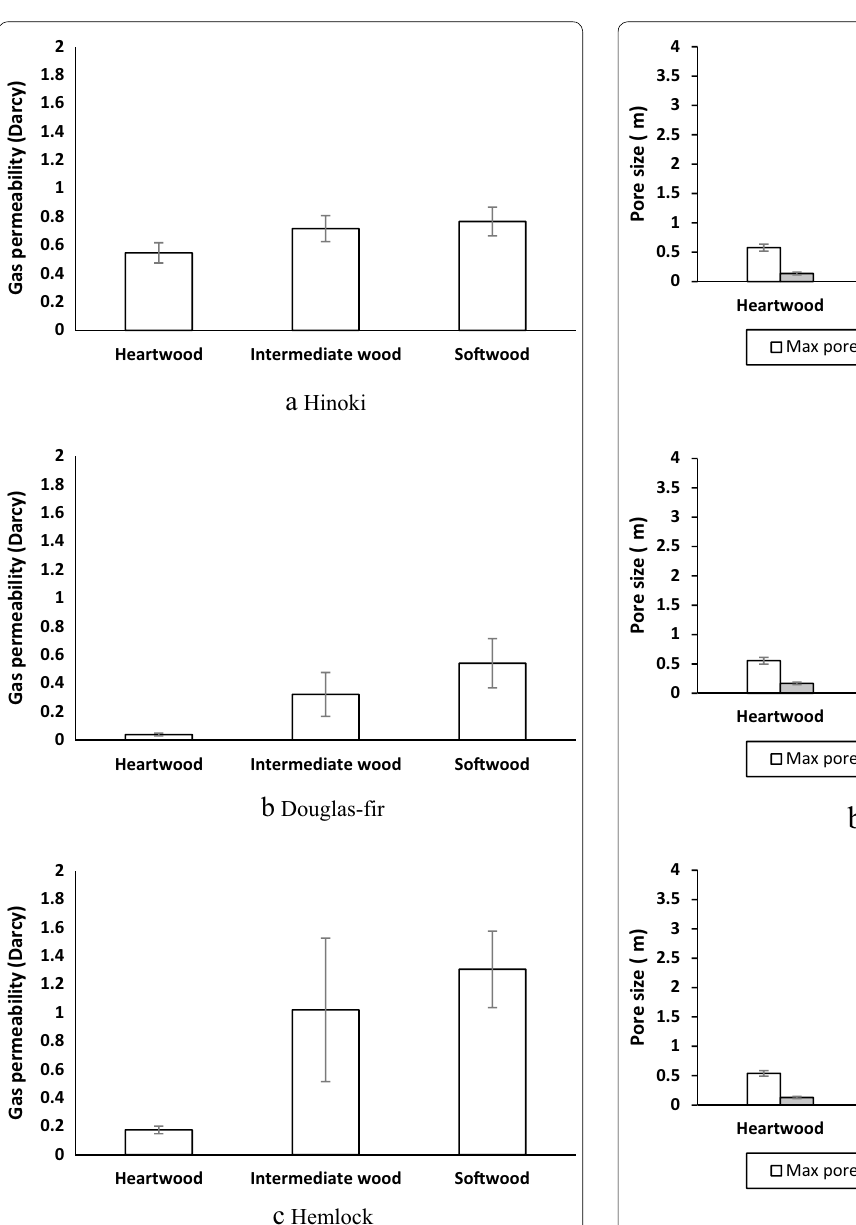
Fig. 5 Results of gas permeability of heartwood, intermediate wood and sapwood in three species of softwood (error bar; standard deviation)